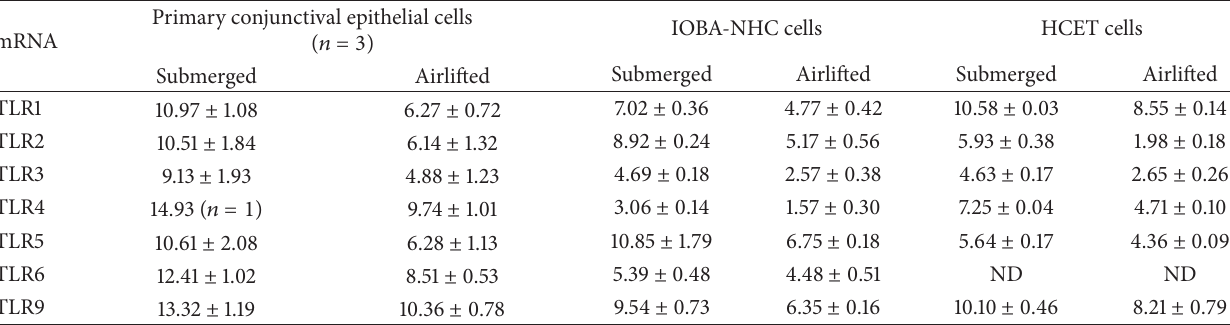
Table 1: Δ Ct of individual TLR mRNA in submerged and airlifted primary human conjunctival epithelial cells, immortalized human conjunctival epithelial cells (IOBA-NHC), and immortalized human corneal epithelial cells (HCET). Primary conjunctival epithelial cells IOBA-NHC cells HCET cells mRNA ( 𝑛 = 3 ) Submerged Airlifted Submerged Airlifted Submerged Airlifted TLR1 10.97 ± 1.08 6.27 ±